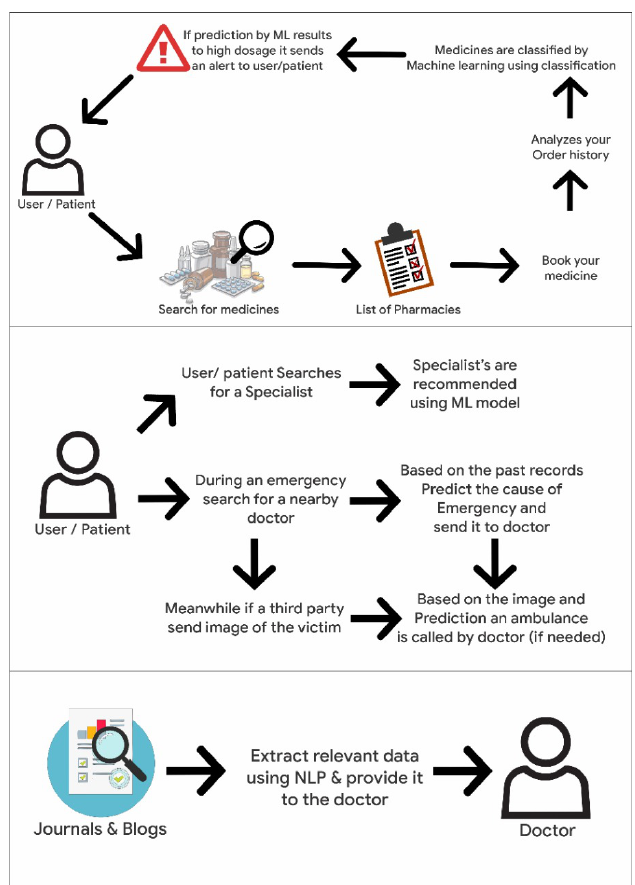
Figure 4.1. Proposed